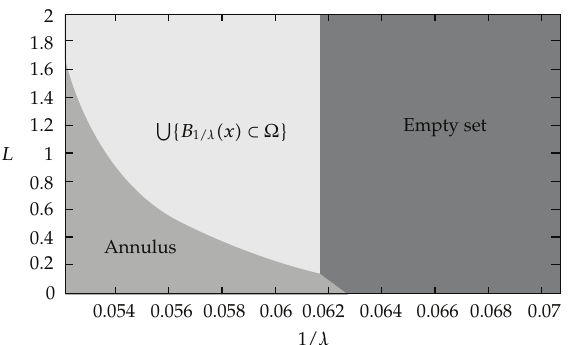
Figure 5: This diagram shows the Σ i with minimum value in (cid:4) 1.2 (cid:5) for the square annulus.